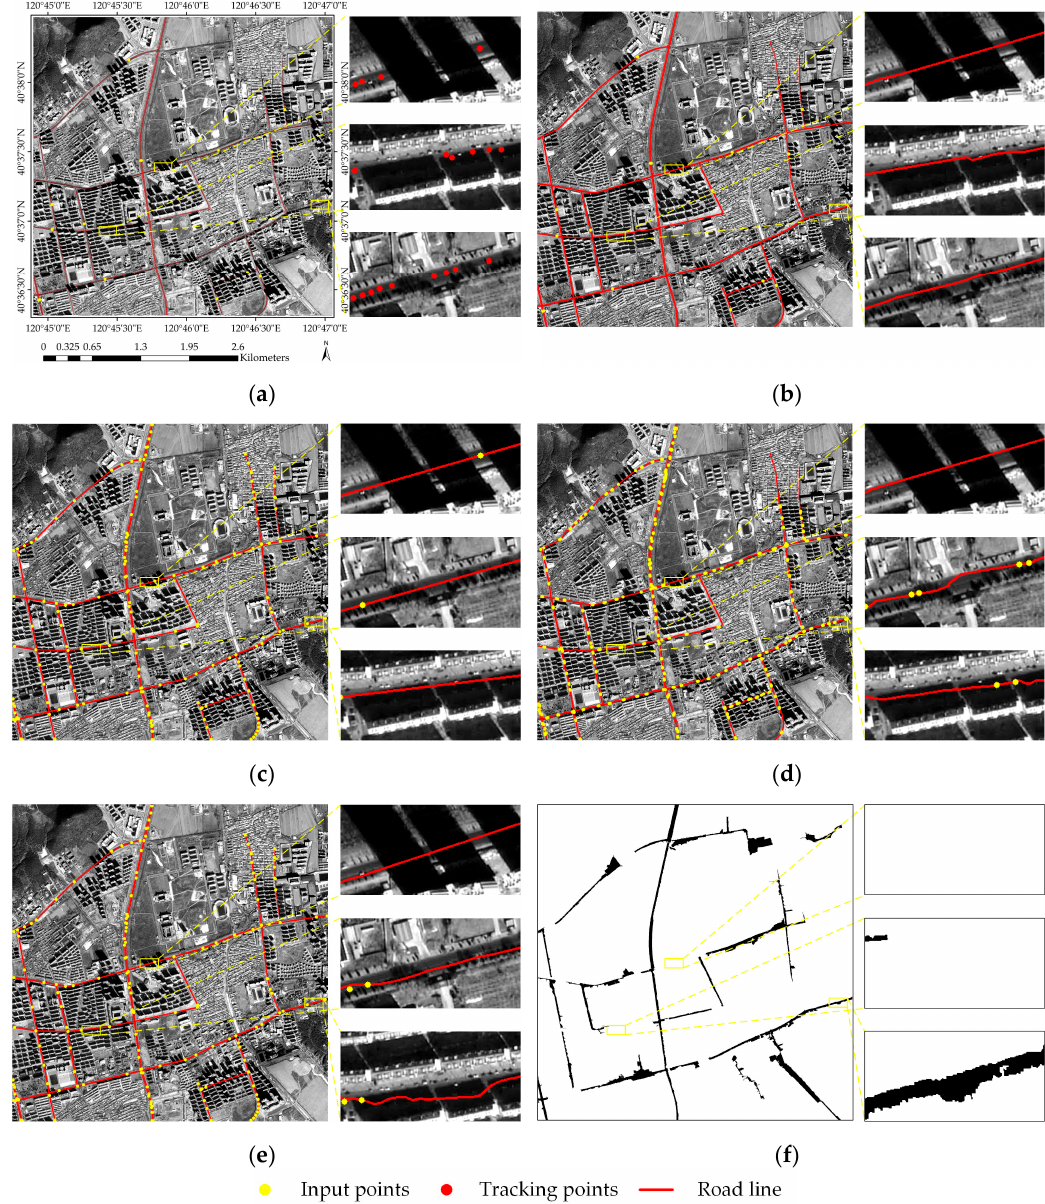
Figure 14. Second study area: ( a ) Tracking point result diagram; ( b ) road extraction result of proposed method; ( c ) road extraction result of the ERDAS method; ( d ) road extraction result of the T-shaped template-matching method; ( e ) road extraction result of the rectangle method; ( f ) road extraction result of the eCognition method.